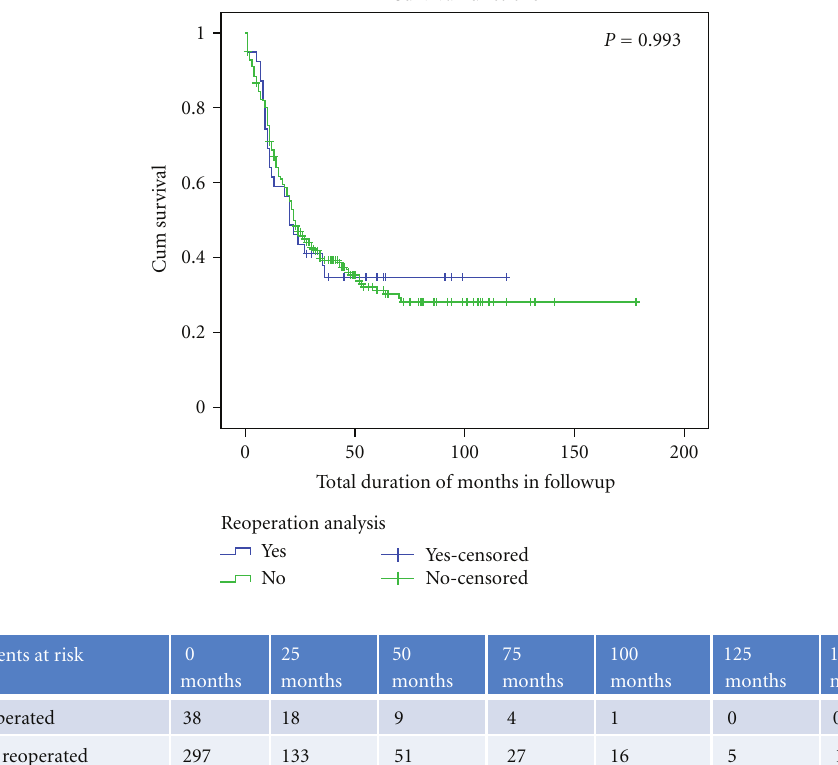
Figure 2: Kaplan Meier survival curve. Comparison of 3year survival of patients undergoing early reoperation versus those patients not requiring